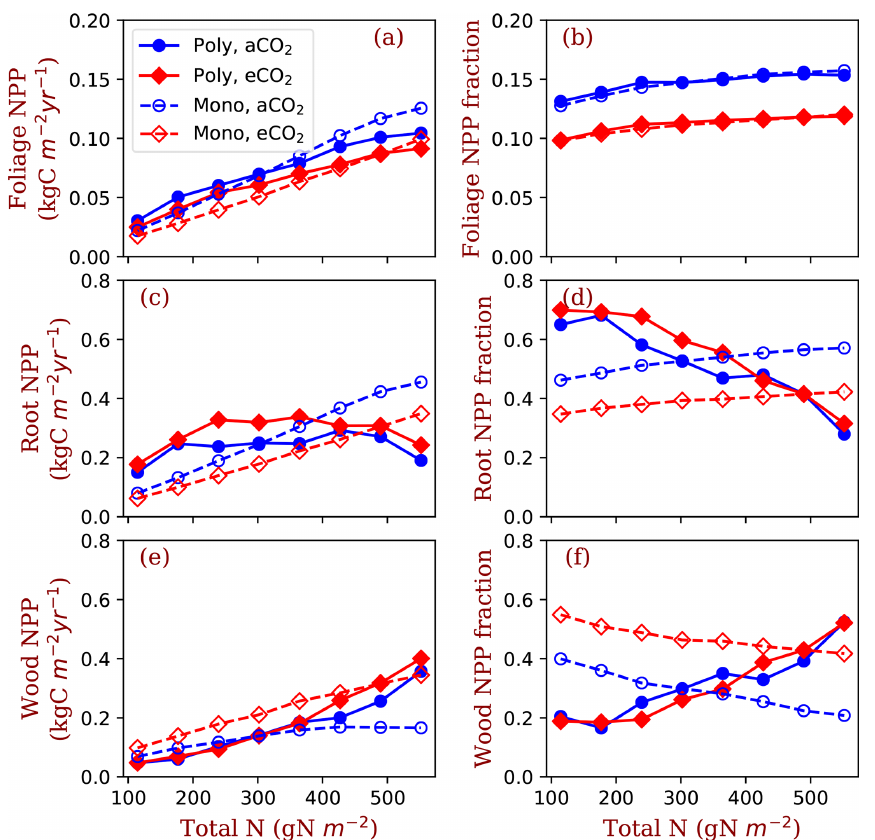
Figure 6. Allocation to leaves, fine roots and wood tissues of the competition and monoculture runs at the eight total nitrogen levels and two CO 2 concentrations ( a CO 2 : 380ppm; e CO 2 : 580ppm). Panels (a) , (c) and (e) show the NPP allocated to the tissues and panels (b) , (d) and (f) show the fractions of the allocation in total NPP. The closed symbols with solid lines represent polyculture runs (Poly). The open symbols with dashed lines represent monoculture runs (only ϕ RL = 4 is shown in this figure, Mono). ϕ RL is the fixed ratio of fine root area to leaf area of a particular